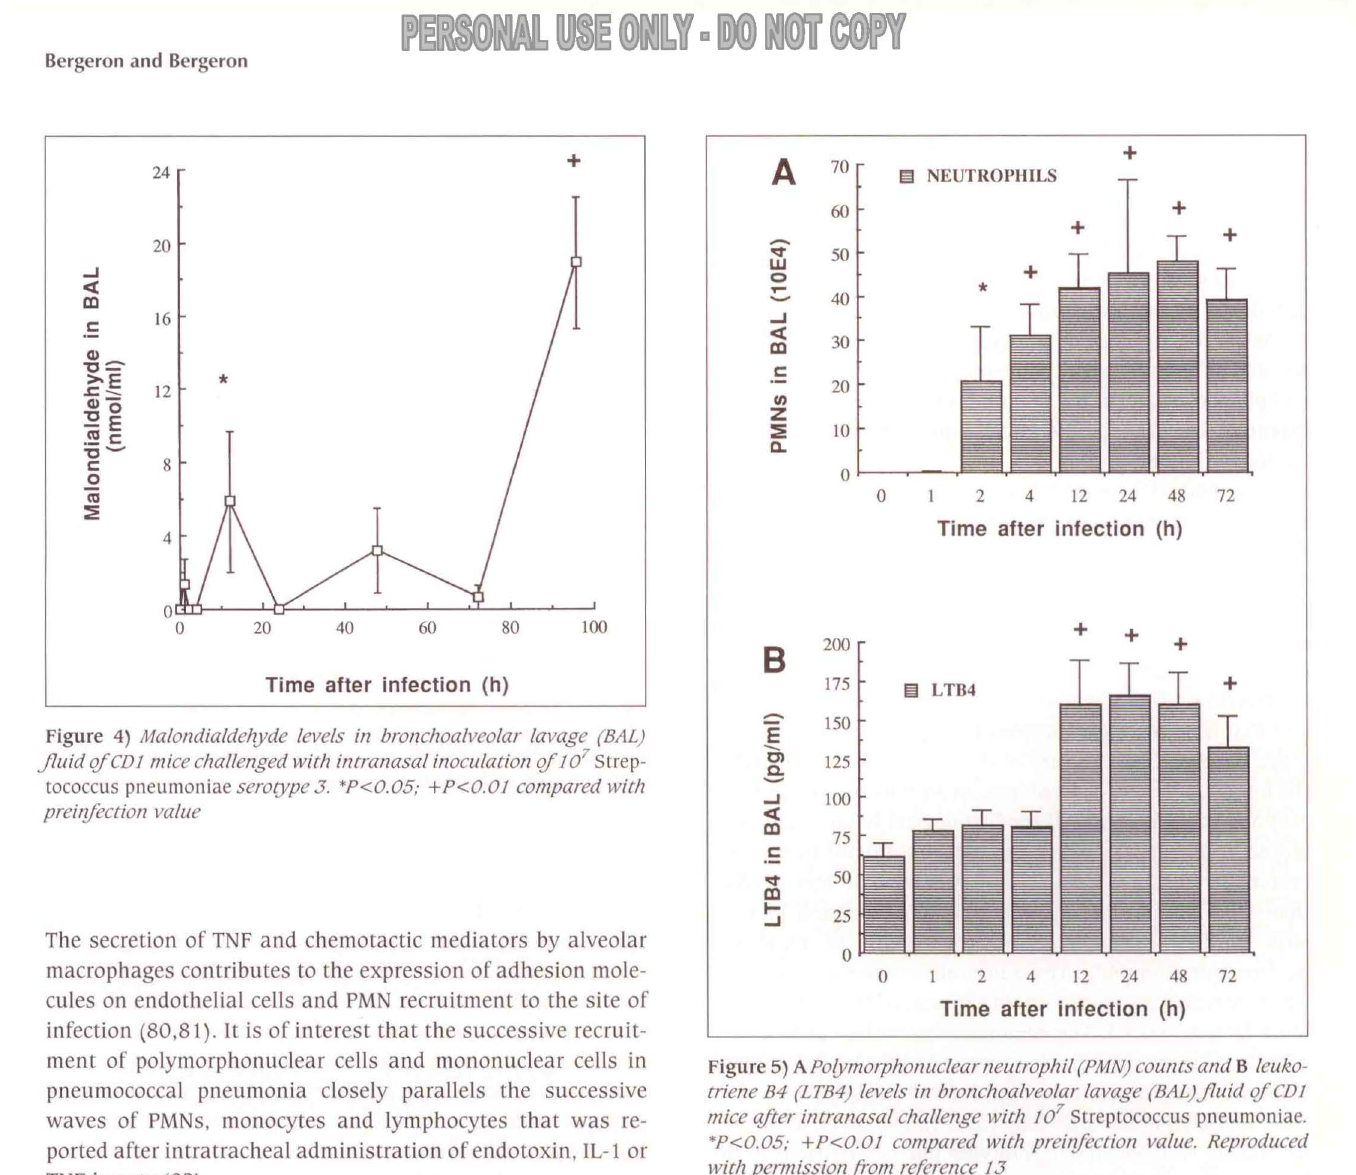
Figure 5) APo/ymOJphonuclear neutrophil (PMN) counts and B leuko triene 84 (lTB4) levels in bronchoalveolar lavage (BALJ.Jluid qf CDI mice efter intranasal challenge with 10 7 StrepLococcus pneurnoniae. *P<0.05; +P<0.01 compared with prei,ifection value. Reproduced with permissionJrom reference